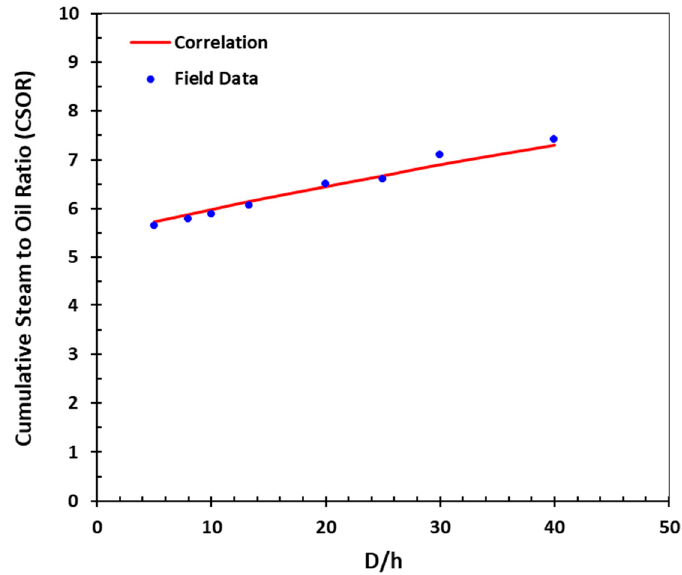
Figure 4. CSOR vs. gross to net thickness ratio for the database analyzed.